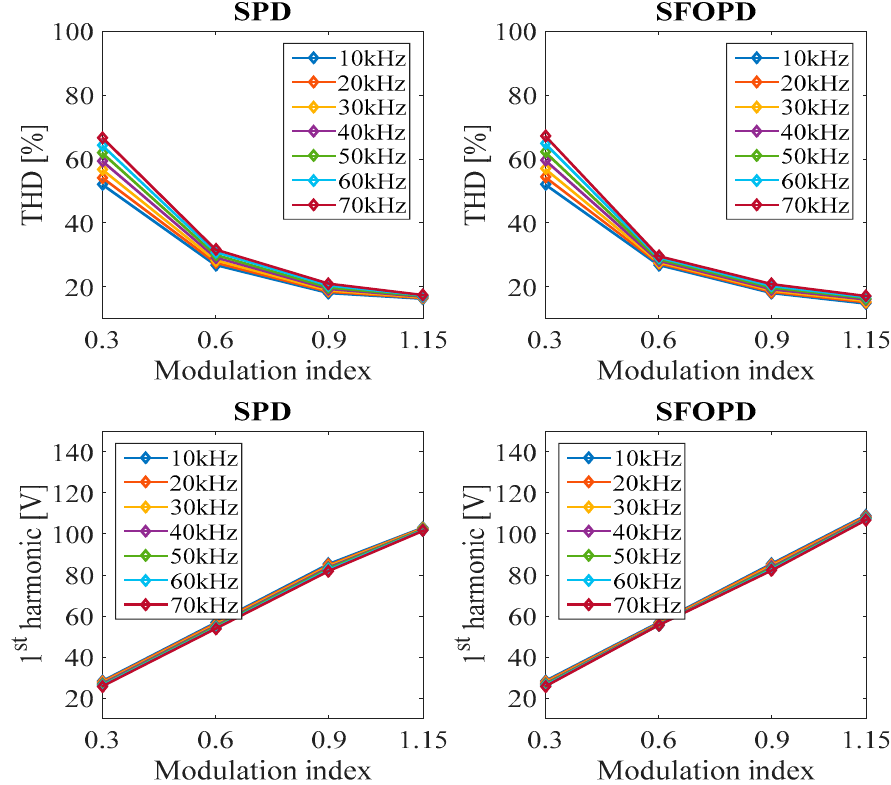
Figure 14. Experimental THD% and fundamental amplitude trends of SPD and SFOPD schemes.